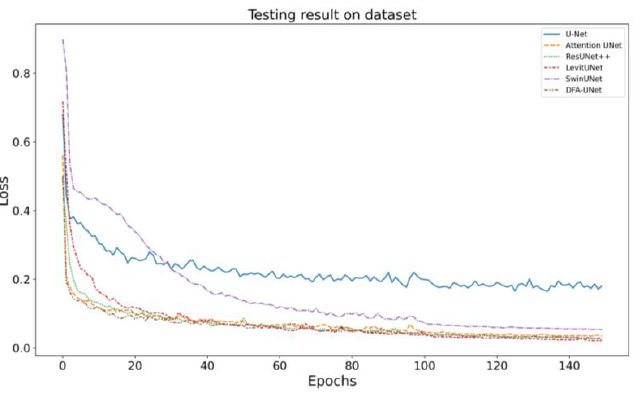
Table 2. Comparison of other parameters of different models.